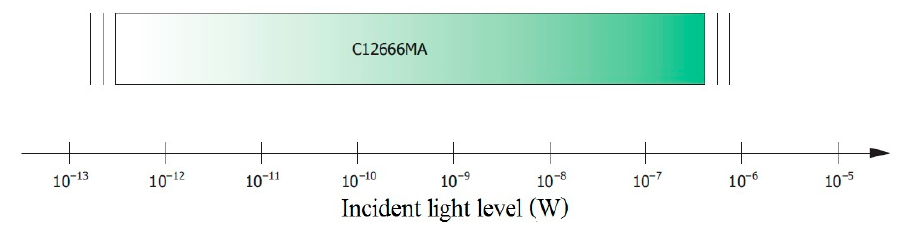
Figure 3. Measurable incident light level on the sensor [25].